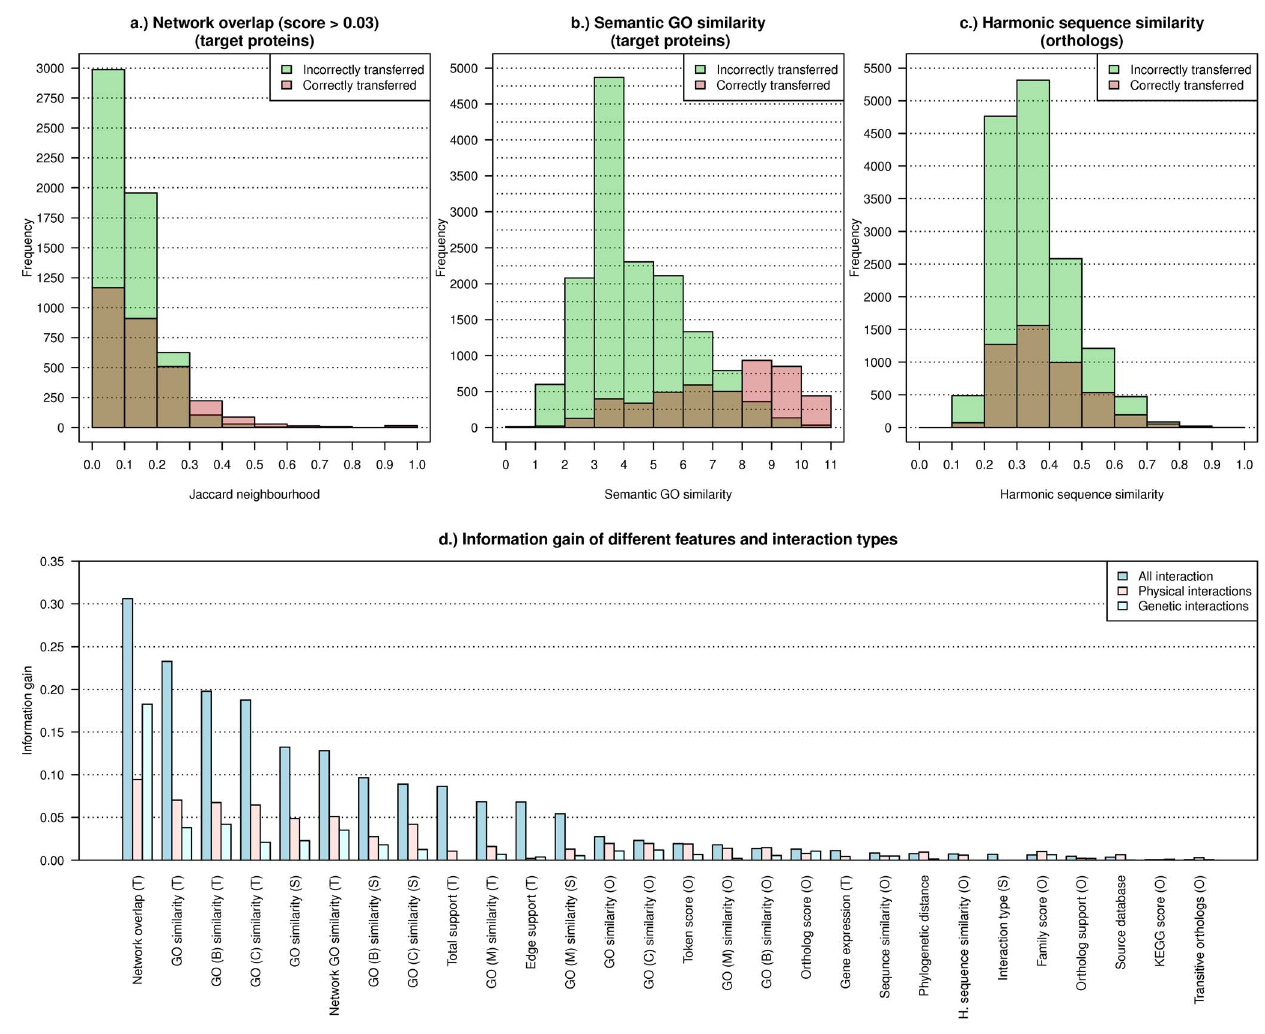
Figure 3. Feature impact. Histogram of the score values for correctly (red) and incorrectly (green) transferred interactions (without interaction type) for the features: a.) Network overlap, b.) Semantic GO similarity and c.) Harmonic sequence similarity. d.) Information Gain of the individual features and experimental settings. For ortholog protein features the average Information Gain of the two orthologous partners is shown. For the features a.) Network overlap and especially for b.) Semantic GO similarity a different distribution for correctly and incorrectly transferred interactions can be observed resulting in a large Information Gain of these features. In contrast, for the harmonic sequence similarity feature only a small difference in the distributions can be observed, which explains the small Information Gain and the filter performance based only on sequence similarity.